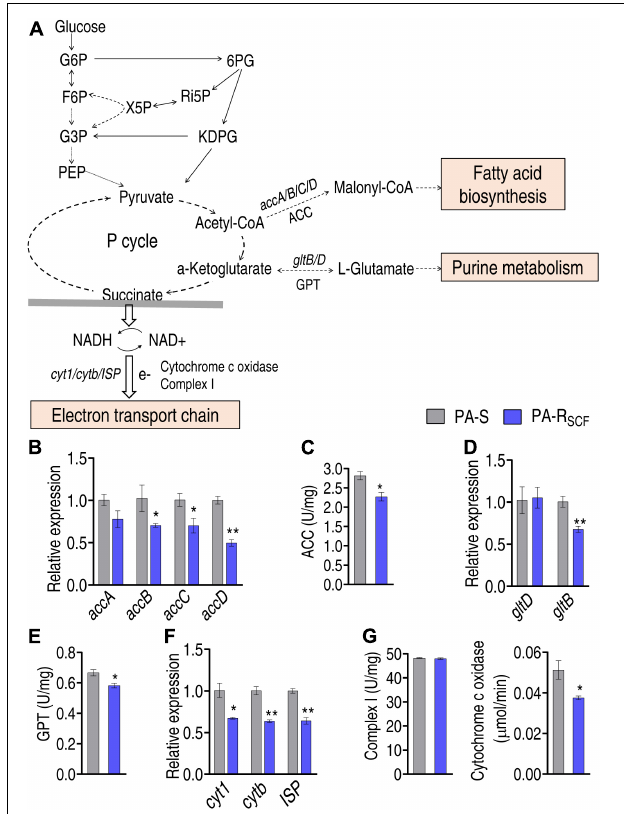
FIGURE 6 | Investigation of the central carbon metabolism-related metabolic pathways. (A) Map showing main central carbon metabolism-related metabolic pathways. The abbreviations are referred in Figure 5A legend. Solid lines represent single-step reaction and dashed lines represent multistep reaction. Arrows indicate the direction of the reaction. (B) Expression of key genes entering biosynthesis of fatty acids. (C) Activity of enzyme entering biosynthesis of fatty acids. ACC, acetyl-CoA carboxylase. (D) Expression of key genes entering glutamate metabolism. (E) Activity of enzyme entering glutamate metabolism. GPT, glutamic-pyruvic transaminase. (F) Expression of key genes entering electron transport chain. (G) Activity of enzyme entering electron transport chain. Results are displayed as mean ± SEM and three biological repeats are performed. Significant differences are identified. * p < 0.05 and ** p < 0.01.